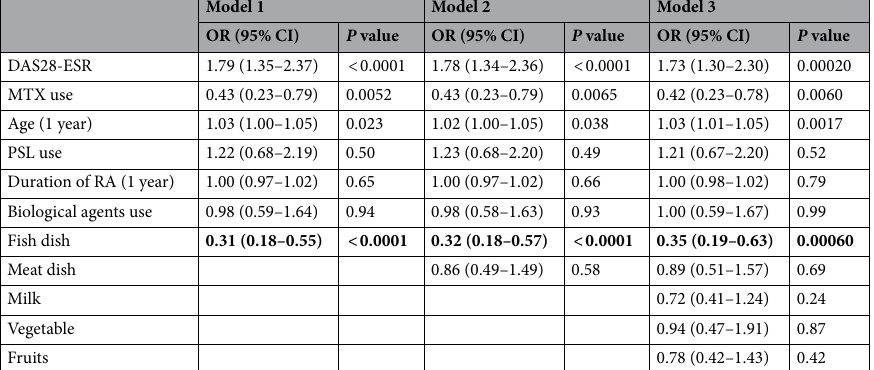
investigation of correlations between frailty and dietary habits in various clinical populations. There are several major limitations in the present study. Although the FFQ in the current study can determine the intake frequency of each type of foods, we cannot estimate the actual total amount of protein intake from the FFQ data and cannot determine whether the benefit of fish consumption is due to increased protein intake or other beneficial compounds. Our cross-sectional study does not imply causation, and the long-term relationship of dietary habits and frailty is still unknown. It is not known whether our findings can be generalized because of clinical factors that may differ in each study, such as epidemiological backgrounds of our participants, a dietary